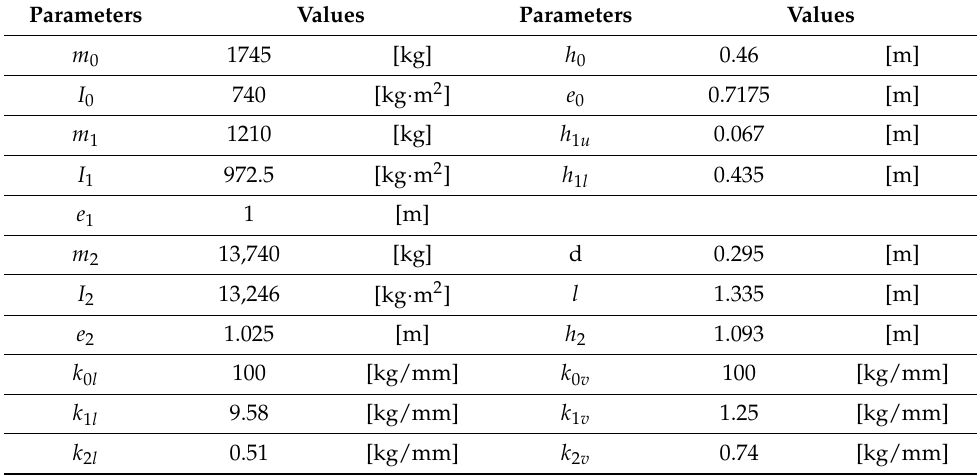
Table 5. Input data for 2D simulations.